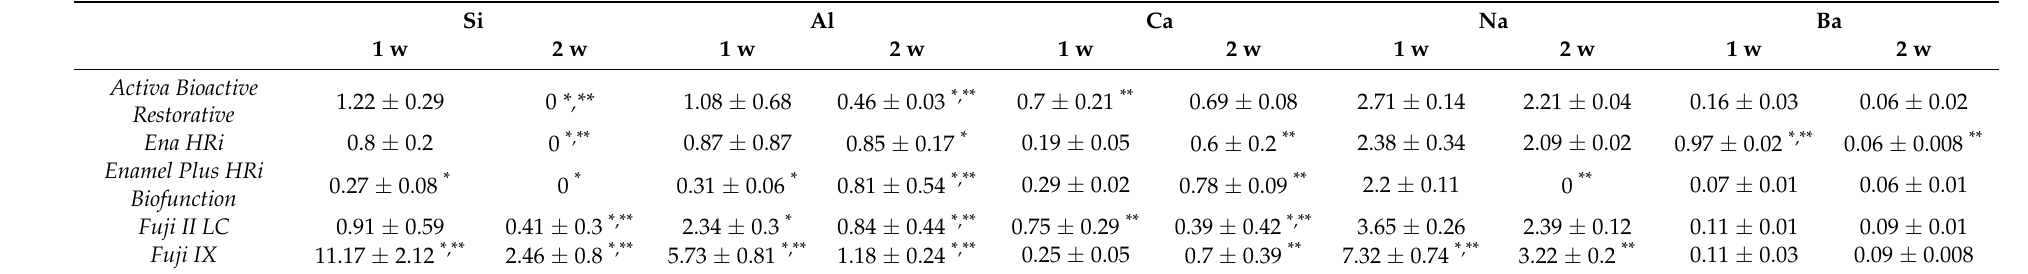
Table 6. Ions released in ppm for both observation period (1 and 2